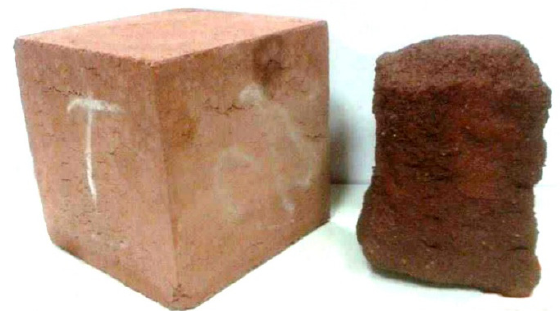
Figure 9. Two samples from a 703 mixture not containing cement. Left: sample not tested for water